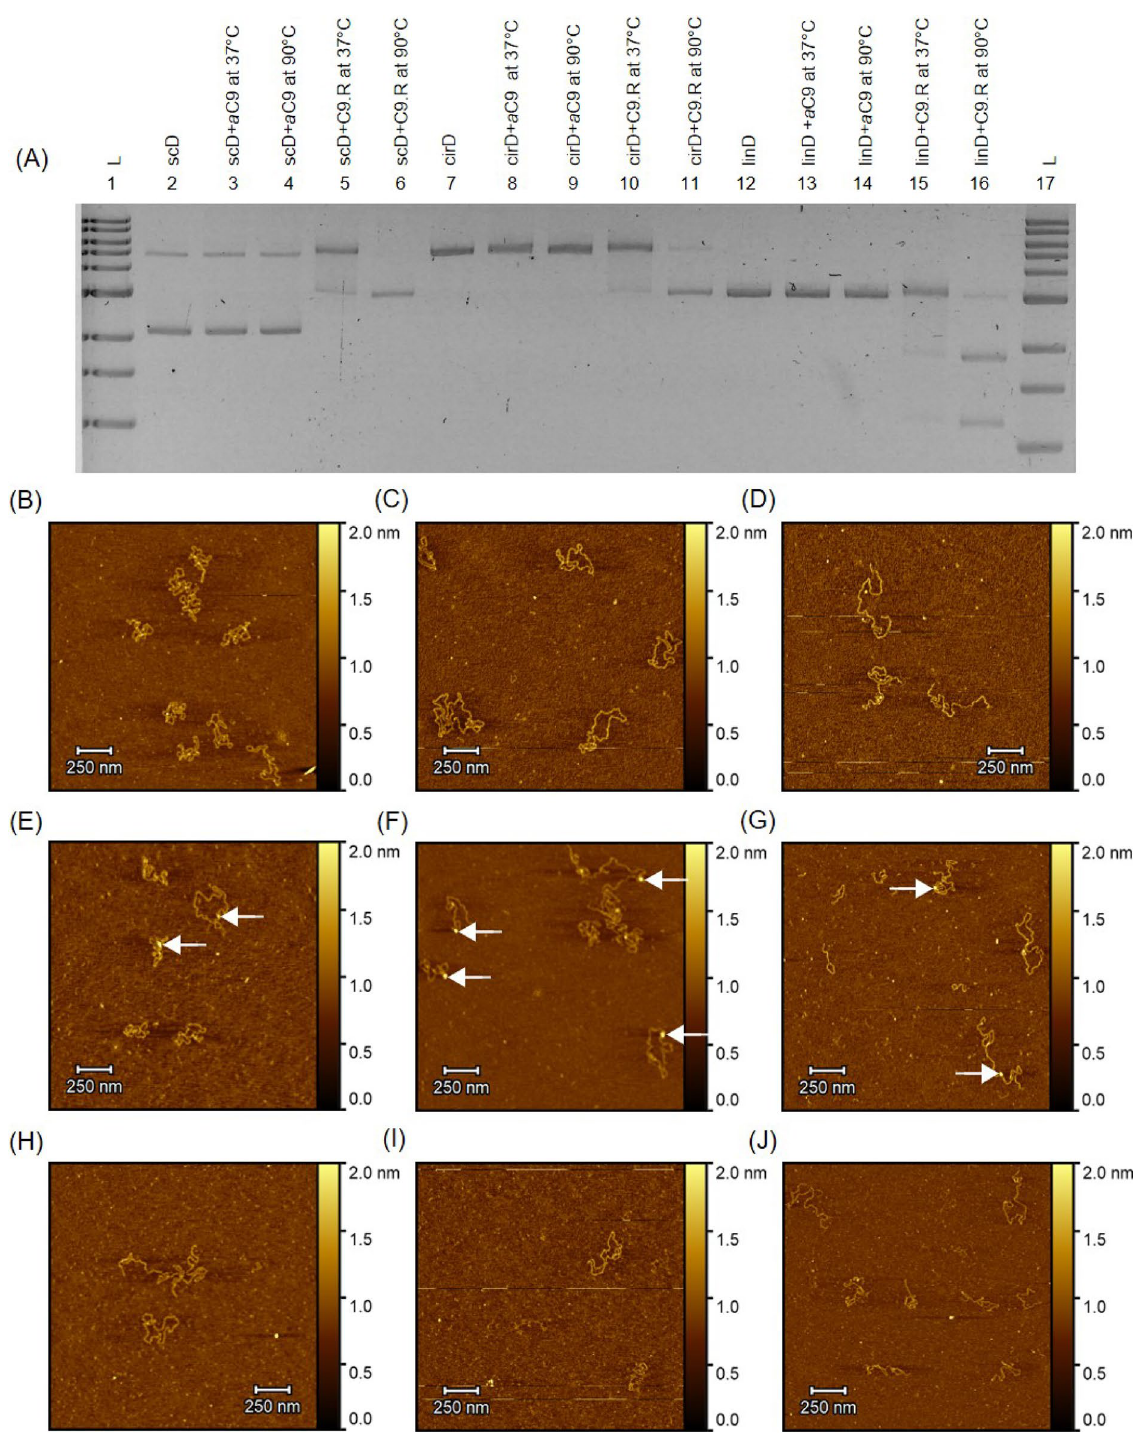
Figure 1. Cas9 binding to different conformations of DNA. ( A ) Gel image showing the Cas9 bound to supercoiled, nicked circular and linear DNA. Lane 1 and 17 show 1 kb ladder. Lanes 2, 7 and 12 show control DNA. Lanes 5, 10 and 15 show the gel shift due to Cas9 bound DNA. Lanes 6, 11 and 16 show the release of cleaved products upon heating. ( B – J ) Shows the AFM images of samples scanned using tapping mode in air. The three columns show supercoiled, circular and linearized plasmids respectively. ( B – D ) Shows AFM images of bare supercoiled, nicked, and, linearized form of the plasmid, respectively. ( E – G ) Shows Cas9-bound (white arrows) states of the three plasmid conformations. ( H – J ) Show heat-released products of Cas9 cleavage of the three plasmid